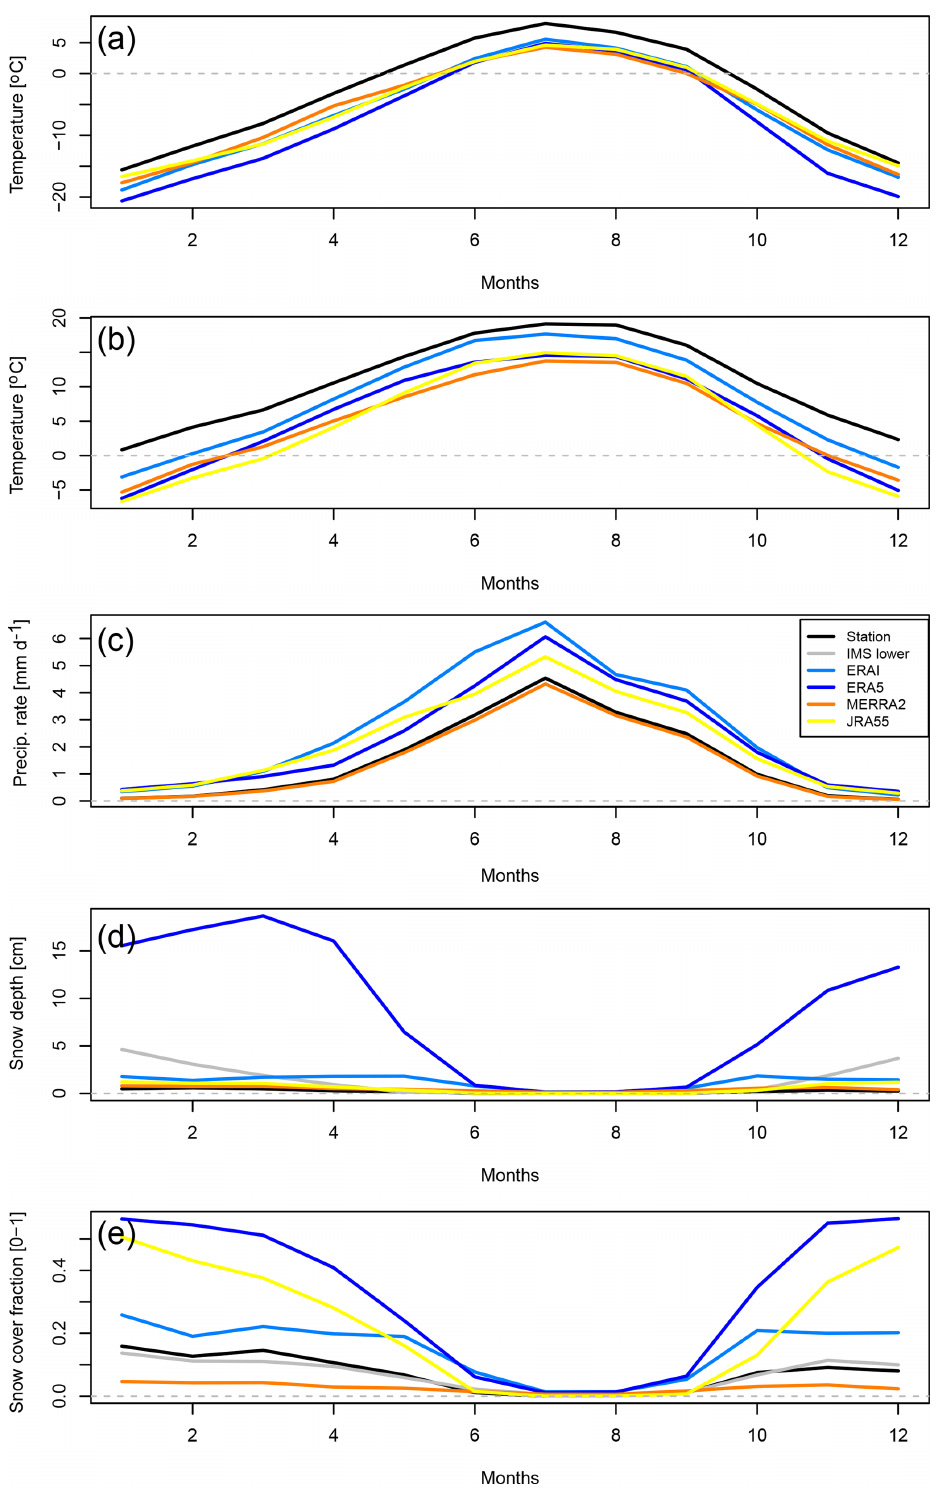
Figure 8. The 5-year mean (2009–2013) monthly-mean seasonal cycle for minimum temperature ( ◦ C) (a) , maximum temperature ( ◦ C) (b) , precipitation rate (in millimetres per day) (c) , SD (in centimetres) (d) , and SCF (between 0 and 1) (e) averaged over all the 33 stations. The grey line refers to IMS (low estimate) for snow cover or to MW for snow